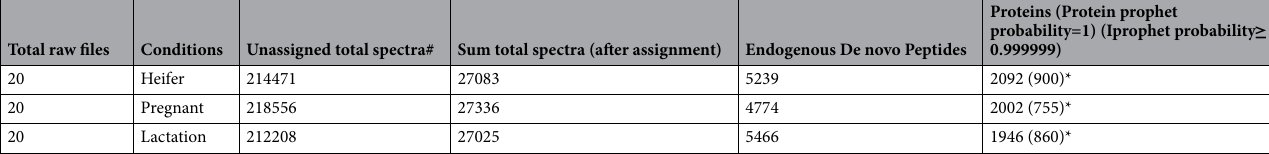
Table 1. # Total number of unassigned spectra acquired in all the raw data mapped in COMET search engine using no enzyme search parameter. *Proteins reported with bold letters asterisk symbol are identified with more than 10 percent sequence coverage peptides of respective protein and all the peptides identified through minimum of 2 independent